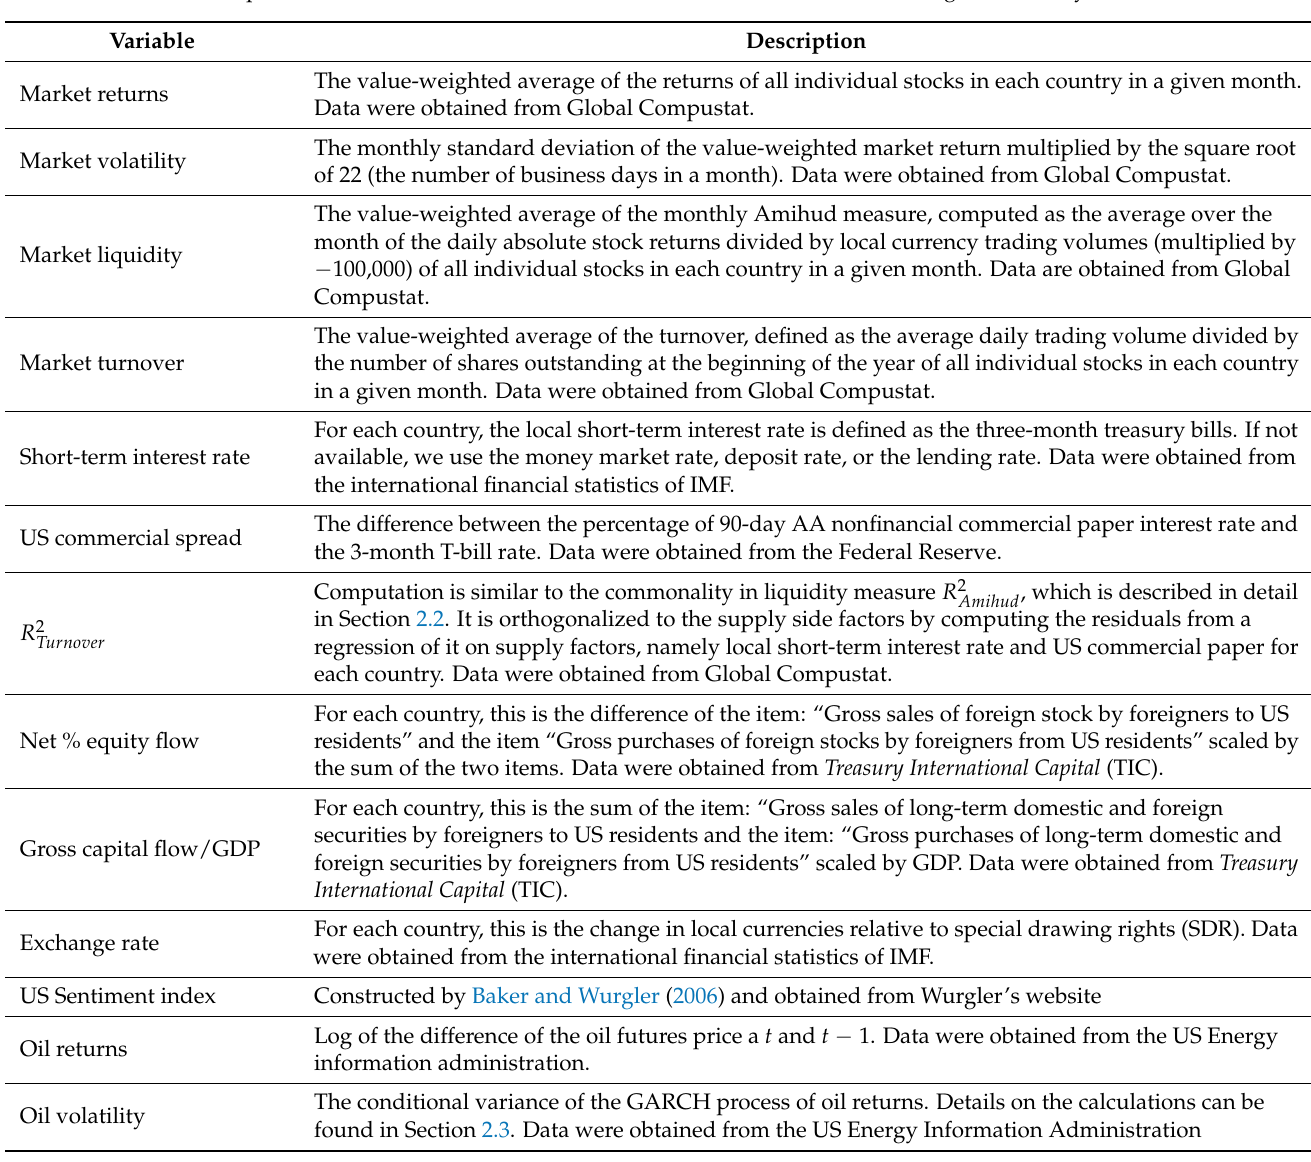
Table A1. Descriptions of the variables. This table describes the variables used in the regression analysis in Section